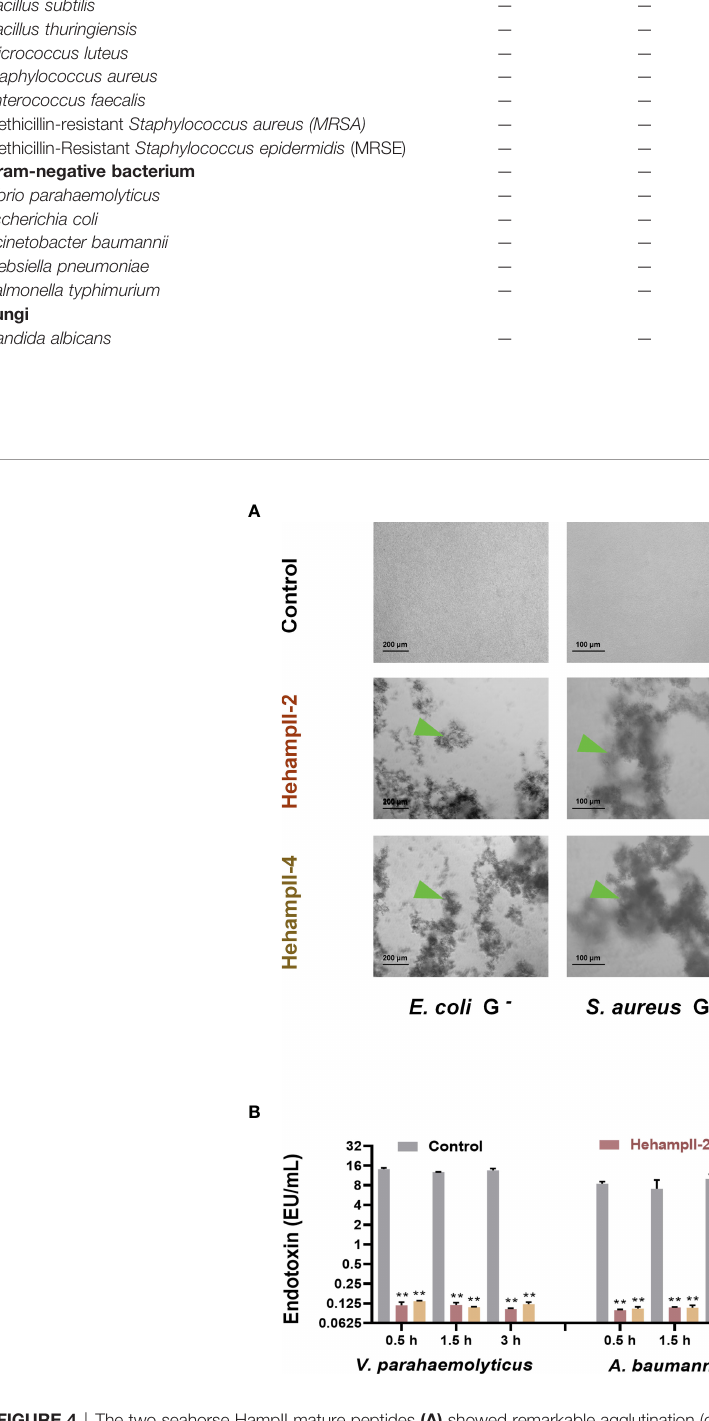
FIGURE 4 | The two seahorse HampII mature peptides (A) showed remarkable agglutination (green triangle points to the agglutinating bacteria), and (B) inhibited the release of bacterial endotoxin signi fi cantly (mean ± SEM, n=3; **, indicate signi fi cant difference compared with control, p < 0.01).